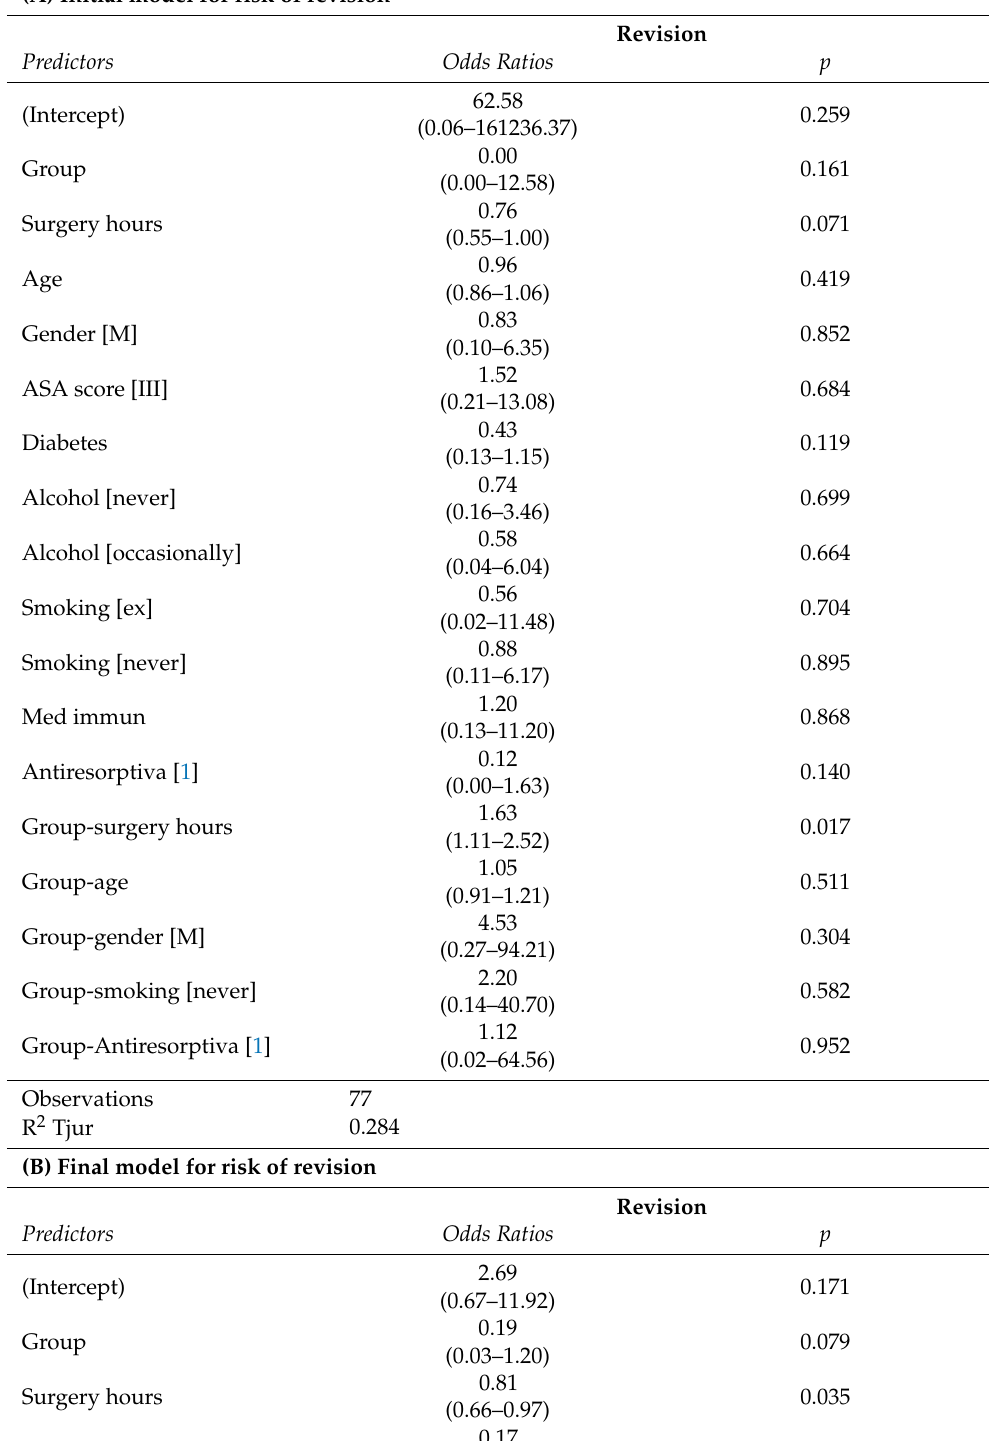
Table 6. Initial ( A ) and final ( B ) model for risk of